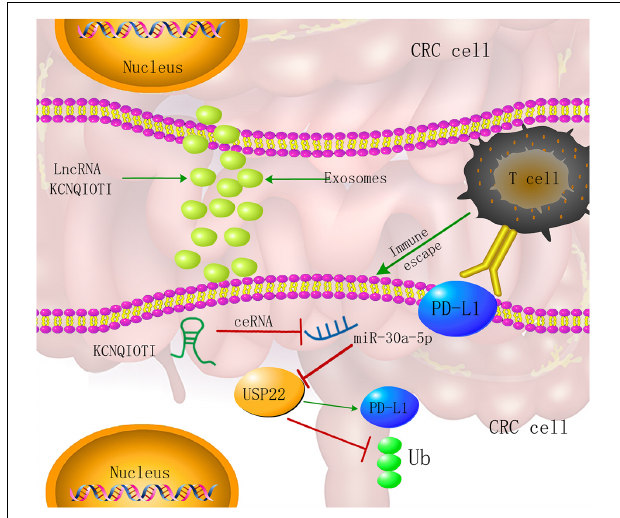
FIGURE 10 | Colorectal cancer (CRC) cell-derived exosome KCNQ1OT1 regulates the mechanism of tumor cell formation through the miR-30a-5p/ubiquitin-specific peptidase 22 (USP22)/programmed death-ligand 1 (PD-L1)